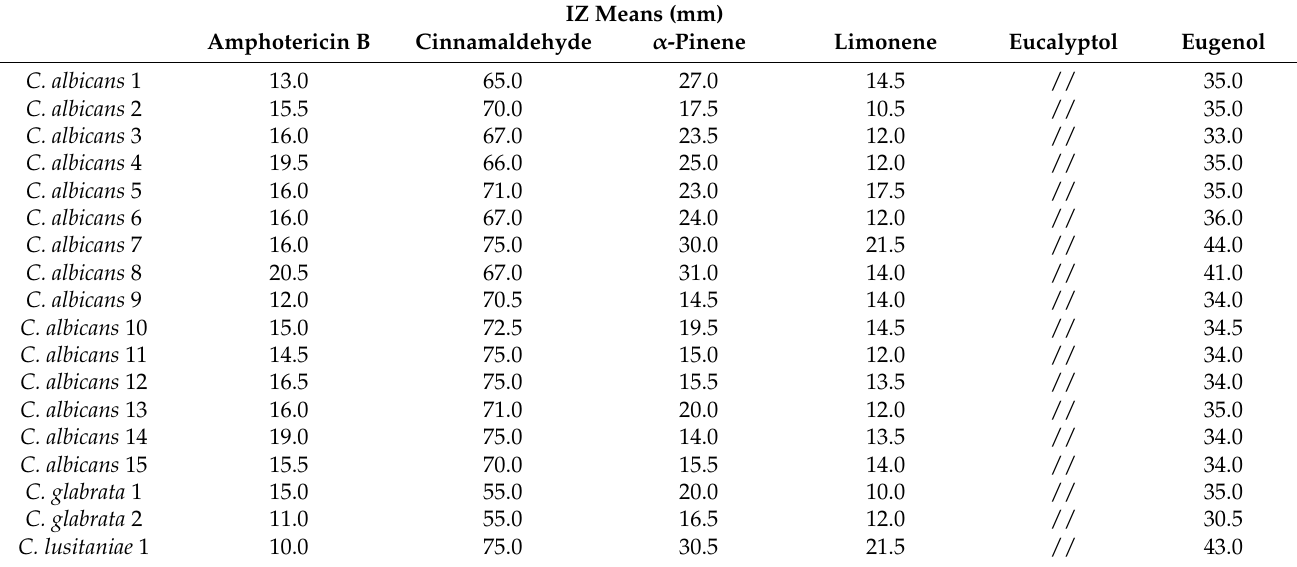
Table 2. Antifungal effects of selected natural compounds against Candida strains evaluated by agar diffusion